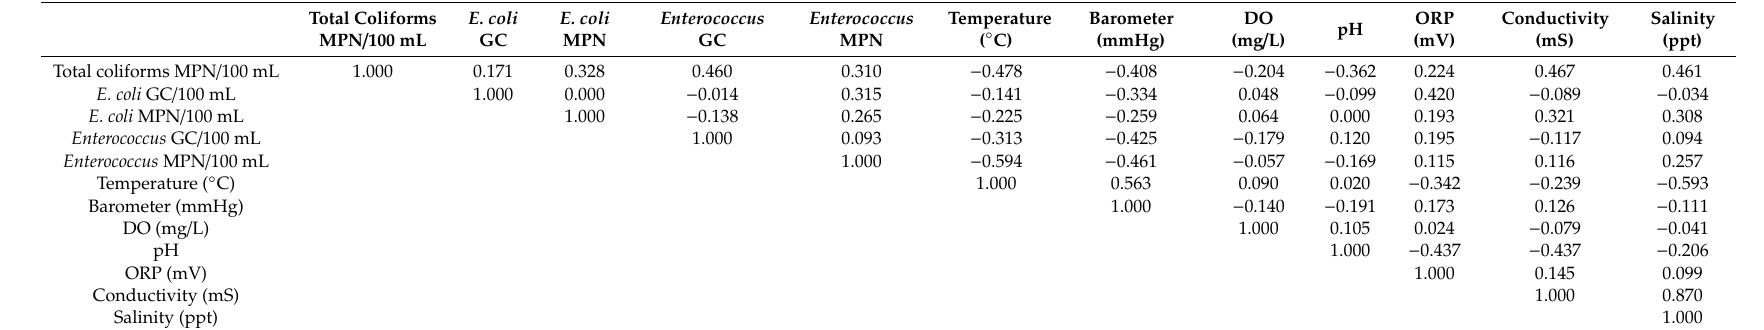
Table 2. Correlation among fecal indicator bacteria and physical